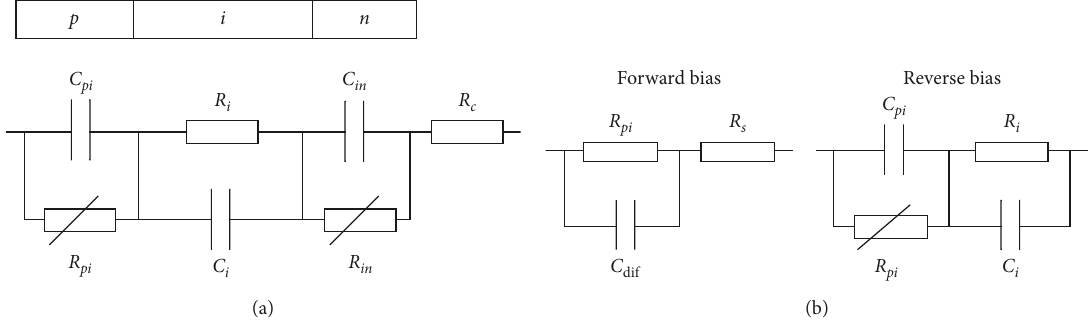
Figure 8: Equivalent circuit diagram for a p - n junction with the intermediate layer of high resistance, constructed on the basis of an equivalent circuit pin diode (a) [49] and a simplified scheme for direct (forward bias) and inverse (reverse bias) connection